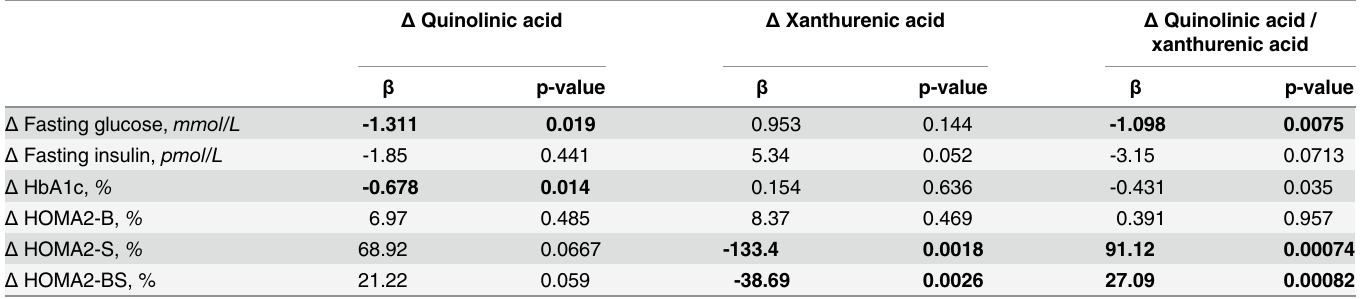
Table 4. Correlations between metabolic trait changes and KPm level changes after